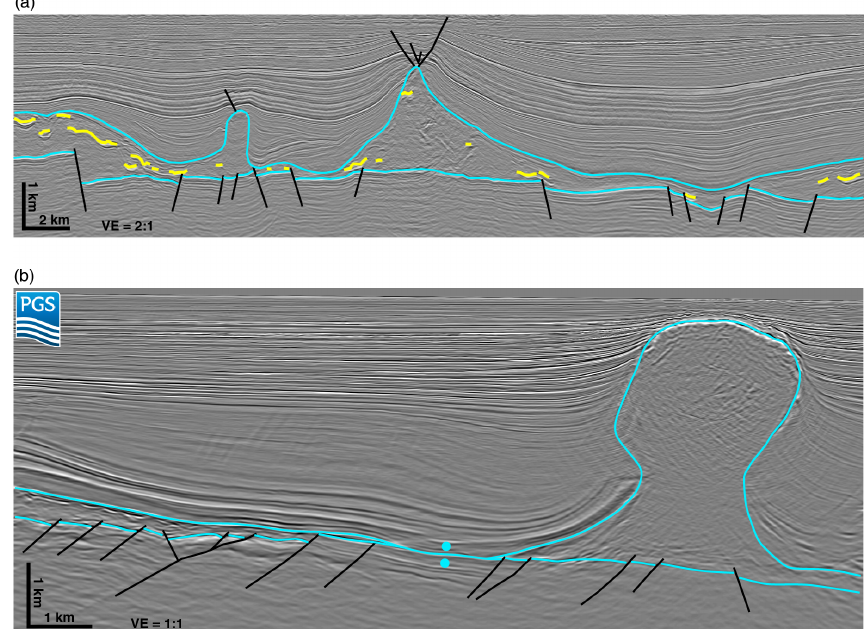
Figure 14. Examples of passive diapirs formed by LES with internal competent beds: (a) 3-D depth-migrated seismic profile (vertical exaggeration 2 : 1) from the Wadden Sea of the onshore Netherlands showing two diapirs formed by the Zechstein salt (between cyan horizons) – very little of the Z3 stringer (yellow) is visible within the diapirs or beneath the flanking depocenters (adapted from Strozyk et al., 2014); (b) 3-D depth-migrated seismic profile (vertical exaggeration 1 : 1) from the Santos Basin with expulsion–rollover structure and passive diapir (data courtesy of PGS Investigação Petrolifera